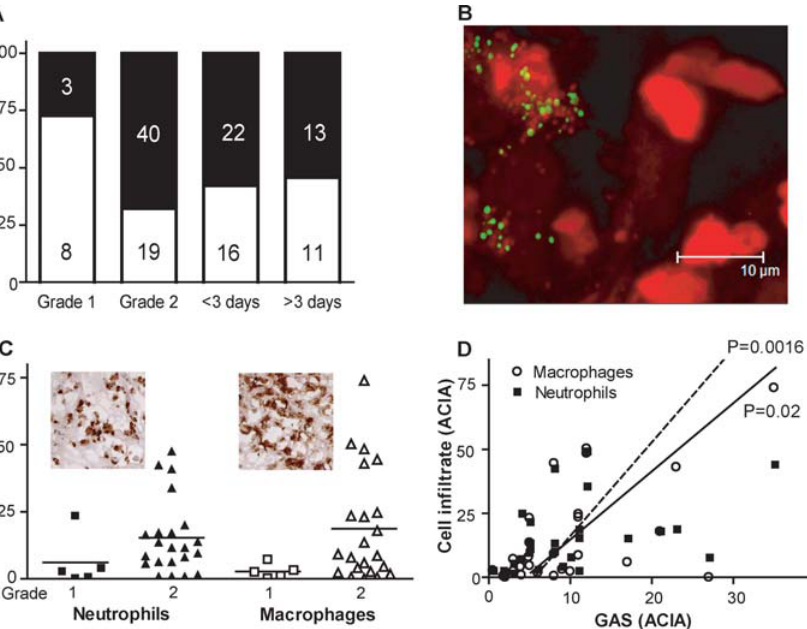
Figure 1. High Bacterial Load and Infiltration of Phagocytic Cells in Tissue Biopsies Tissue biopsies of clinical grades 1 or 2 (for definitions, see Methods) were stained for the presence of bacteria, macrophages (CD68-positive cells), and neutrophils (neutrophil elastase-positive cells). The stained biopsies were evaluated by ACIAs, and the ACIA value is shown in the figure; for details, see Methods. (A) Percentage of biopsies with low or high bacterial load (indicated by white and black bars, respectively) in biopsies divided according to their clinical grade (1 or 2) or by time of collection after diagnosis. Numerals within the bars denote number of biopsies. Low or high bacterial is defined by the threshold ACIA value of (cid:1) 5, as previously described [4]. The viability of GAS in the tissue was assessed by use of a bacterial viability stain that stains